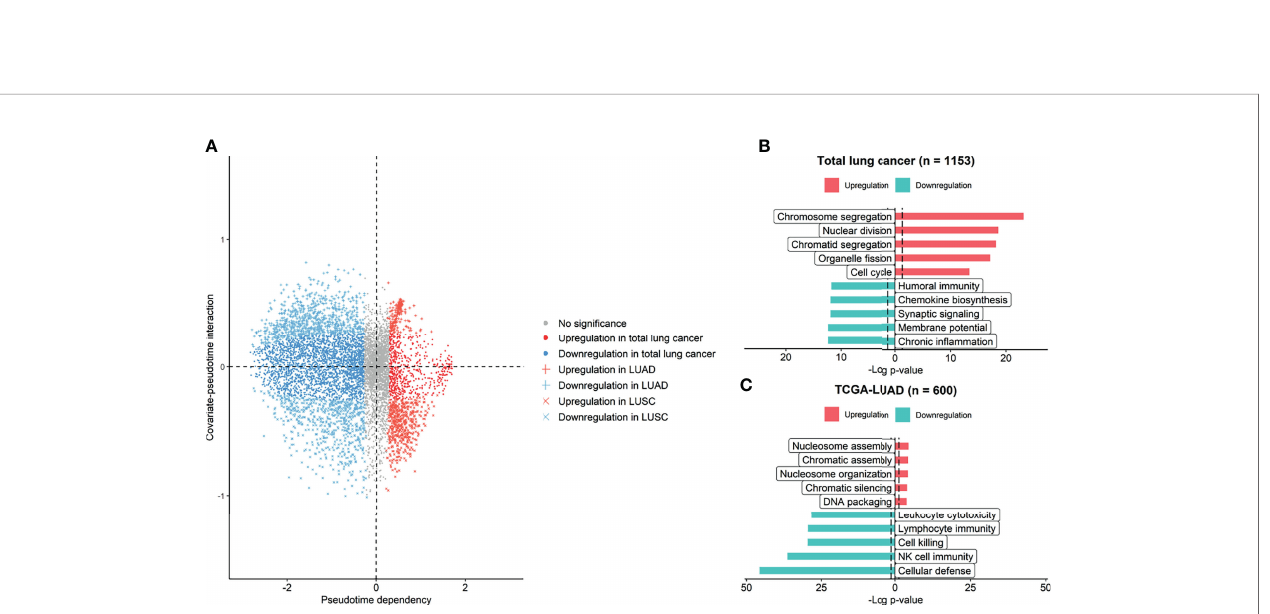
FIGURE 4 | Genes and molecular functions upregulated and downregulated over pseudotime. (A) Genes upregulated and downregulated over pseudotime were selected and plotted. A total of 3197 genes showed signi fi cant correlations with pseudotime in total lung cancer. A total of 1031 genes showed signi fi cant correlations in LUAD samples, and 1126 genes showed signi fi cant correlations in LUSC samples. (B) In total lung cancer samples, molecular functions related to cell division were upregulated over pseudotime. (C) In LUAD samples, those related to natural killer cell activity were downregulated over pseudotime, and those related to cell division were upregulated.